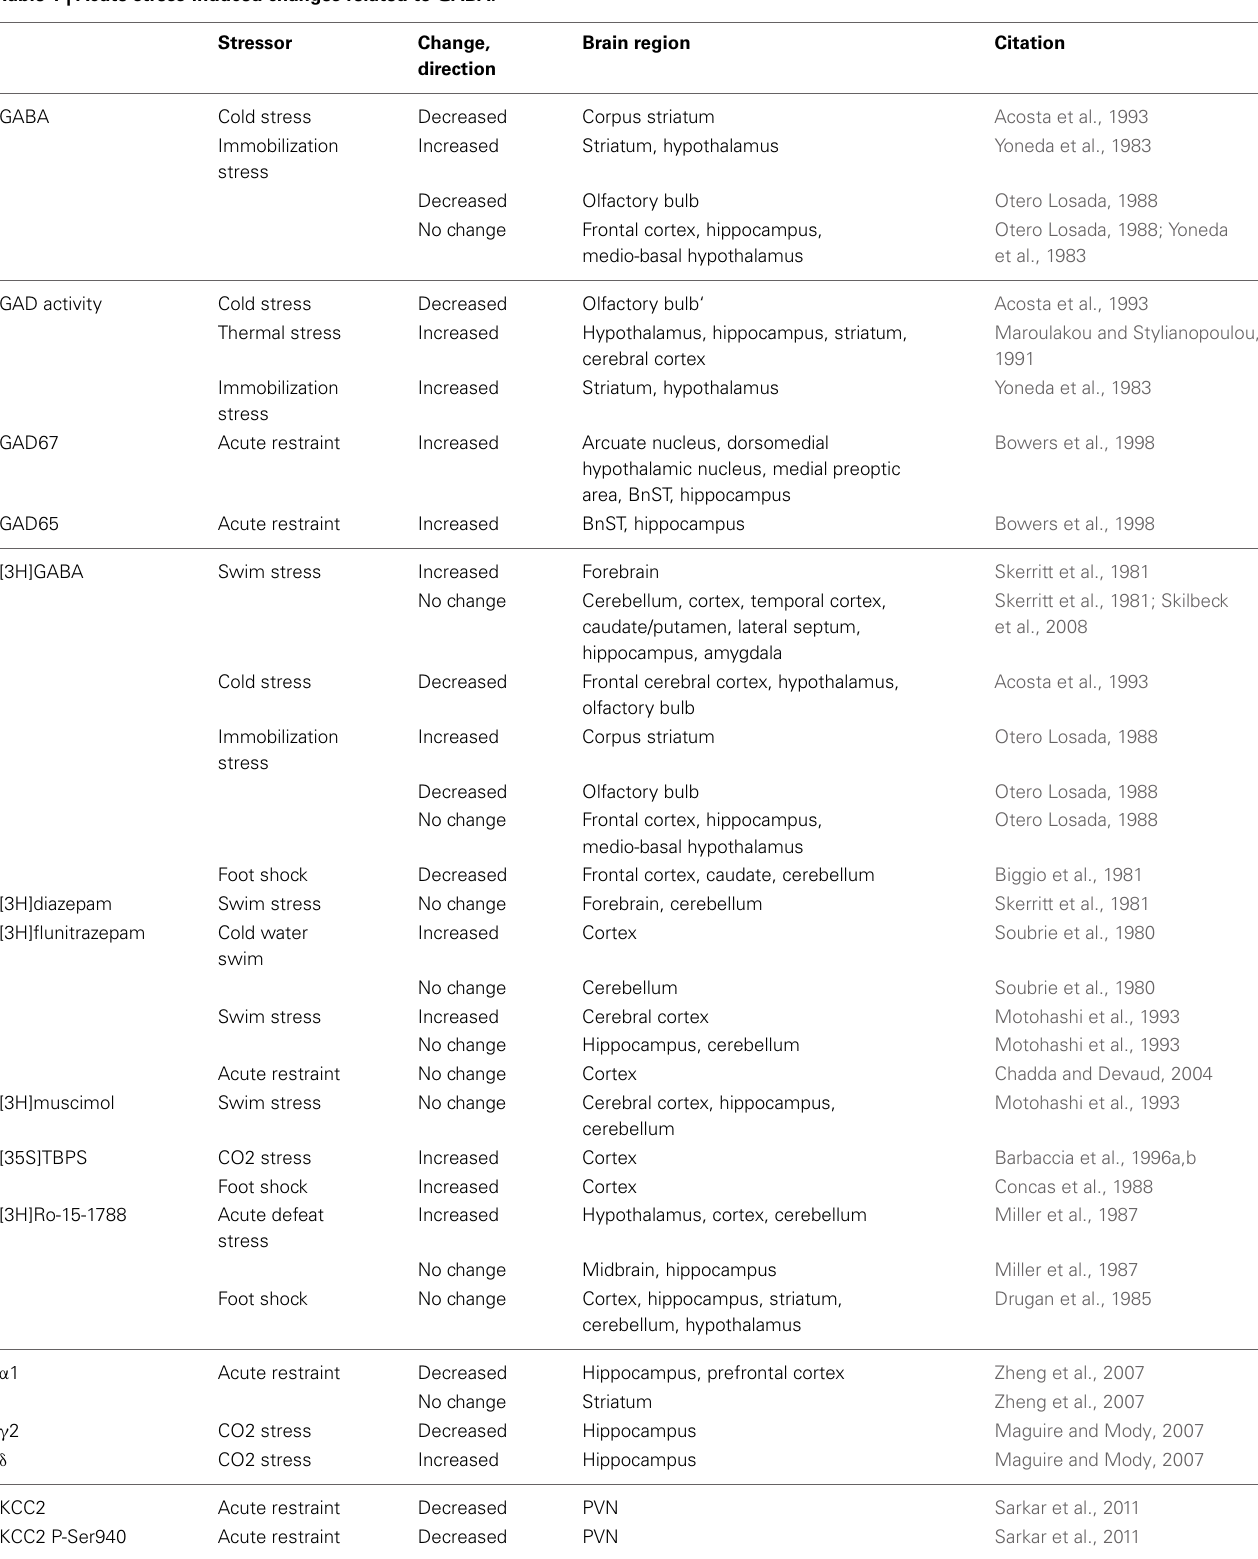
Table 1 | Acute stress-induced changes related to